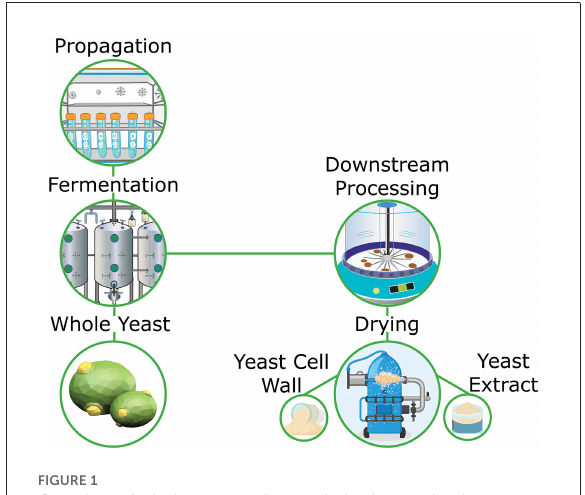
FIGURE1 Overview of whole yeast and yeast derivative